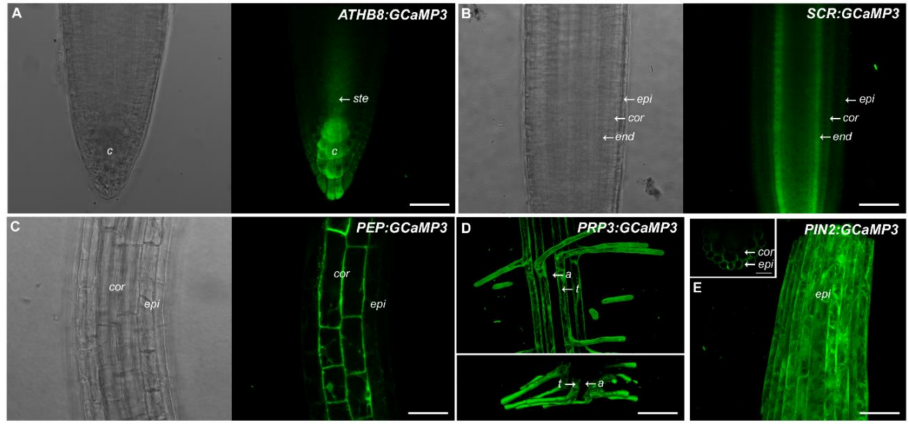
Figure 2. Expression of GCaMP3 in specific root cell types. Representative bright-field and confocal images of primary roots of 5-day-old A. thaliana seedlings expressing ATHB8:GCaMP3 ( A ), SCR:GCaMP3 ( B ), and PEP:GCaMP3 ( C ), respectively. ATHB8:GCaMP3 is expressed in the columella with some fluorescence visible in the stele. SCR:GCaMP3 is expressed in the endodermis and PEP:GCaMP3 is expressed in the cortex. Maximum projection images (top panel in ( D )) and computer reconstructed transversesection(lowerpanelin( D ))oftherootmaturationzoneofseedlingsexpressing PRP3:GCaMP3 show fluorescence confined to the trichoblasts. A maximum projection image of the root elongation zone of seedlings expressing PIN2:GCaMP3 ( E ). The small box on the upper right corner of panel E shows a computer reconstructed cross-section of the primary root of a PIN2:GCaMP3 -expressing line. The image was generated from 50 optical sections taken at 0.50 µ m intervals. Note that GCaMP3 is predominantly expressed in the epidermis and cortex. c = columella; ste = stele; epi = epidermis; cor = cortex; end = endodermis; t = trichoblast; a = atrichoblasts. Scale bar: 50 µ